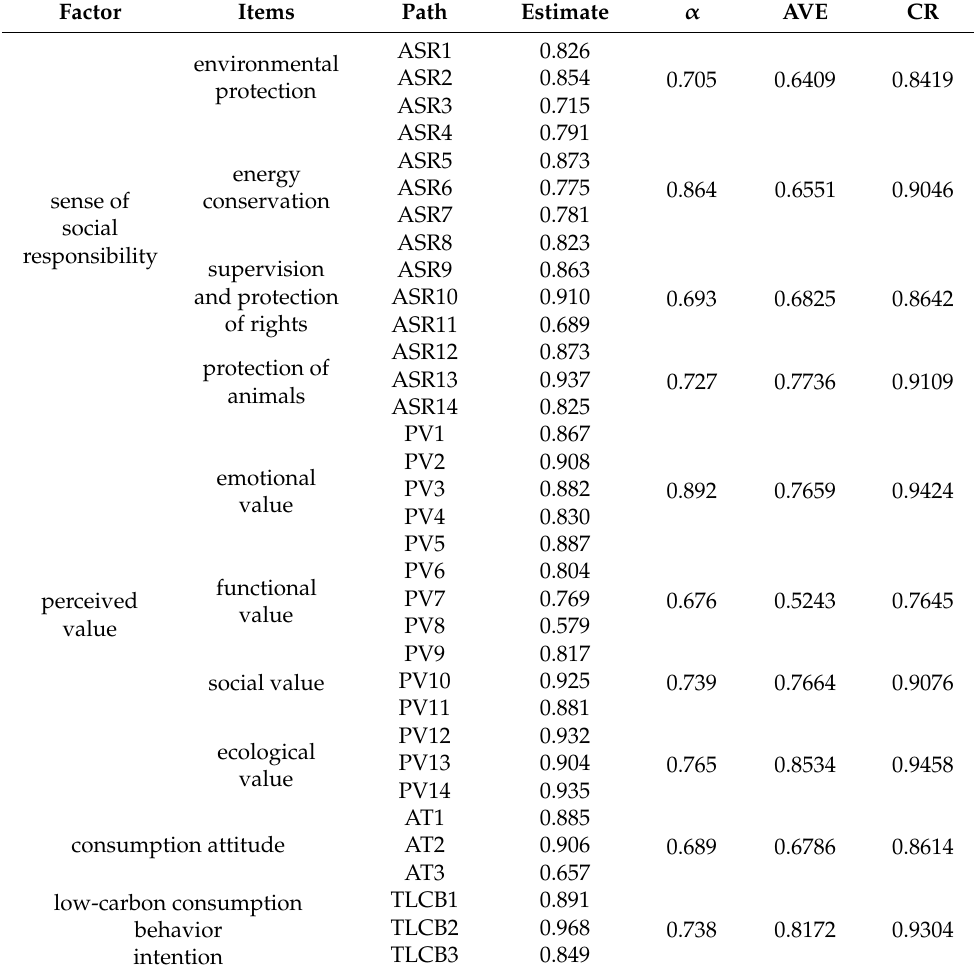
Table 6. Convergent